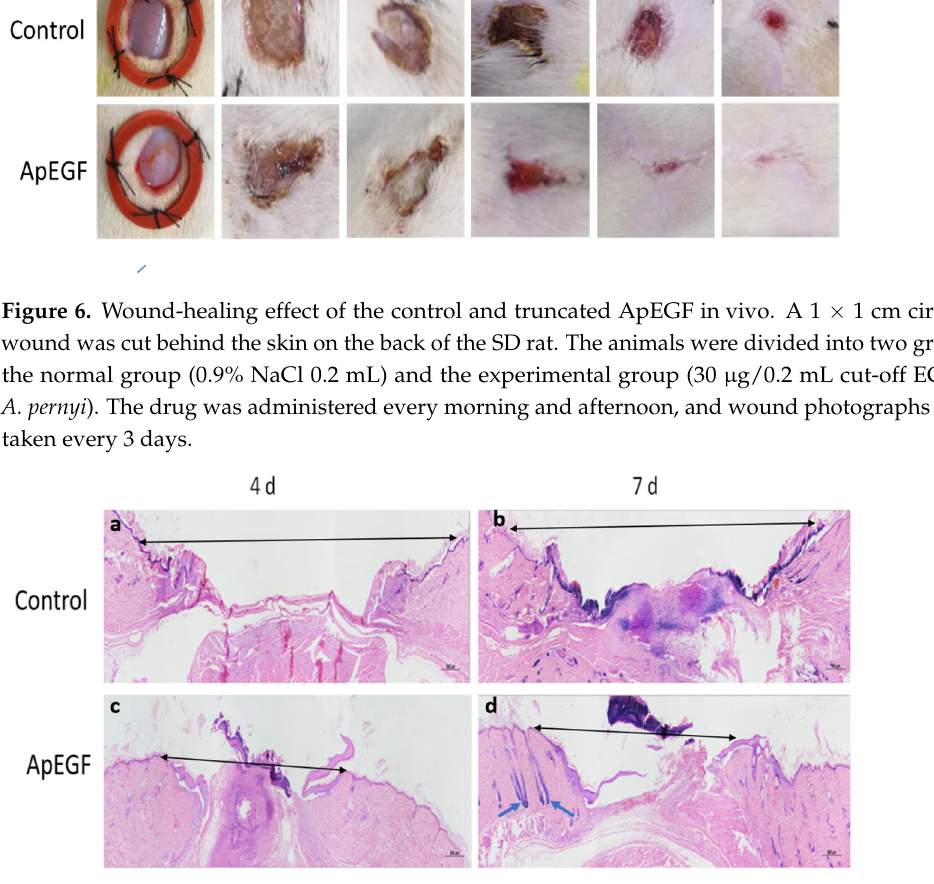
Figure 7. Hematoxylin and eosin staining analysis of round-wound healing in mouse models at 4 and 7 days after treatment with the control and truncated ApEGF. ( a ): HE-staining image of the blank group on the fourth day of wound treatment; ( b ): HE-staining image of the blank group on the seventh day of wound treatment; ( c ): HE-staining image on the fourth day of wound treatment with truncated ApEGF; ( d ): HE-staining image on the seventh day of wound treatment with truncated ApEGF. Black arrows indicate wound distance; green arrows indicate hair follicles.